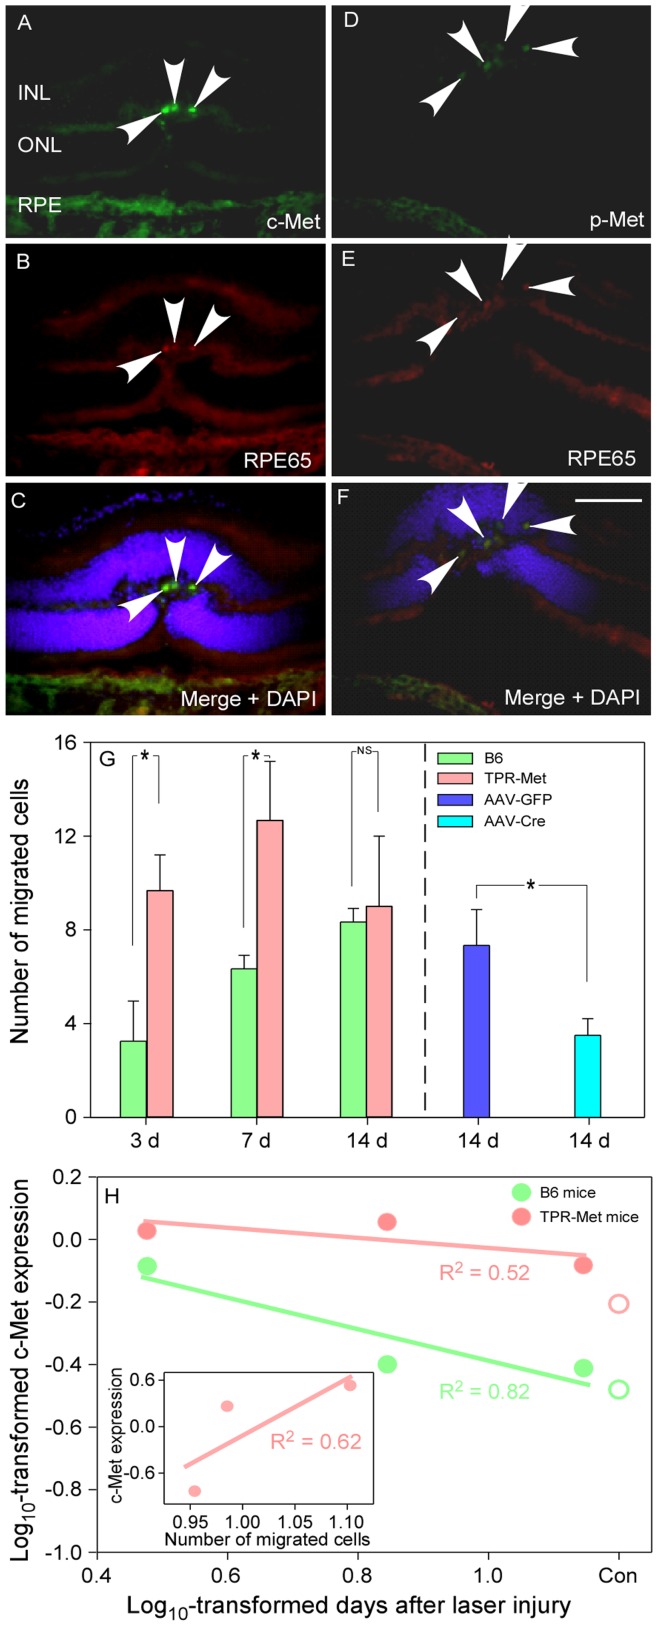
Migration of RPE cells into outer retina 7 days after to injury in B6 mice.RPE cells were observed to migrate into ONL and expressed both c-Met and p-Met (A – E); RPE65 expression confirmed that migrating cells were indeed RPE (C and F). RPE migration was observed as early as 3 days after injury. More robust RPE migration was observed in TPR-Met mice (left side in G panel). In AAV-Cre injected mice, significantly fewer migrating cells were found compared with their AAV-GFP injected counterparts (right side in G panel, * P<0.05, independent samples t-test). These observations indicate that higher c-Met expression could induce more RPE cells to migrate. Significant linear association was confirmed between c-Met expression and duration of laser injury, specifically from day 3 to day 14 in both B6 mice (y = −0.50× +0.11, R2 = 0.82) and TPR-Met mice (y = −0.16× +0.13, R2 = 0.52) (H). On day 14 after the laser injury, expression of c-Met in both mice gradually decreased back to baseline (control level, open circles on the right side). But the process in B6 mice may be faster (slope value, -0.50) than in TPR-Met mice (slope value, -0.16). In addition, a significant linear regression was found between the concentration of c-Met and the number of migrated RPE cells in the c-Met over-expressed TPR-Met mice (y = 0.83× +1.02, R2 = 0.62) (inserted graph in H panel, the values on x-axis and y-axis were log10-transformed according to the original measurements). These findings strongly suggest that higher levels of c-Met expression could induce more RPE cells to migrate. The scale bar for all images: 100 µm.